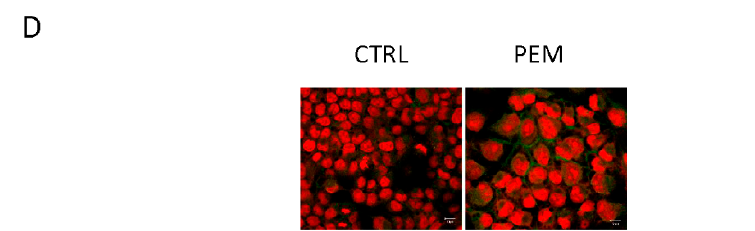
Figure 1. Modulation of programmed cell death ligand-1 (PD-L1) levels by chemotherapeutic drugs in non-small-cell lung cancer (NSCLC) cell lines. ( A ) A549, Calu-6, H292, and H322 cells were cultured in complete medium and after 24 h, the cells were collected and PD-L1 expression was evaluated by flow cytometry and quantified as molecules of equivalent fluorochrome (MEF). ( B ) Cancer cells were treated with increasing concentrations of the indicated drugs for 72 h. IC 50 values ± SD were calculated using GraphPad Prism 6.00 software. ( C ) NSCLC cells were treated with gemcitabine, cisplatin, paclitaxel, vinorelbine, or pemetrexed at IC 50 concentrations. After 3 days, PD-L1 levels were analyzed by flow cytometry. ( D ) Confocal immunofluorescence analysis of PD-L1 expression in H322 cells maintained in the absence or in the presence of 100 nM pemetrexed for 72 h; green fluorescence indicates the positivity to PD-L1. The nuclei were stained with Draq5 (red fluorescence). Scale Bar: 10 µ m. Data in ( A ) and ( B ) are mean values ± SD of three independent experiments. Results in ( C ) and ( D ) are representative of two independent